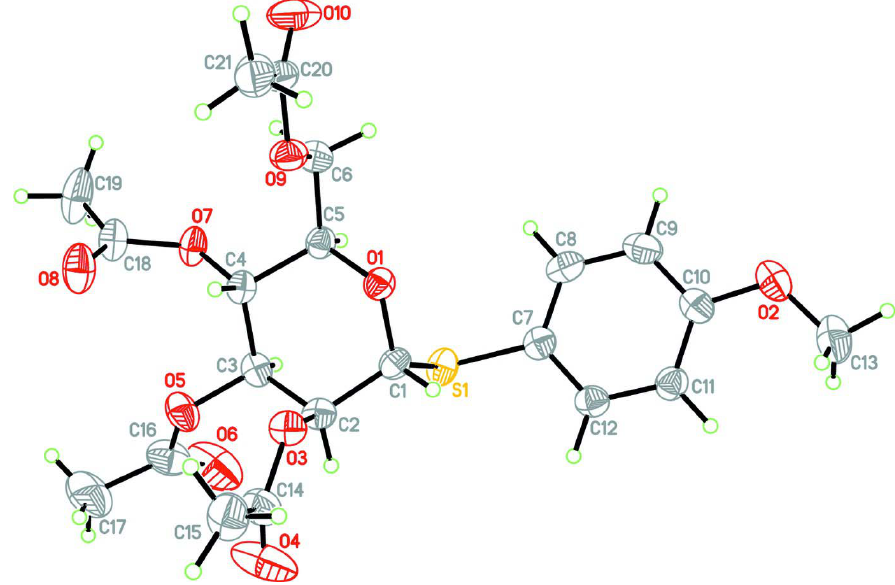
Figure 1 Synthesis of (I).